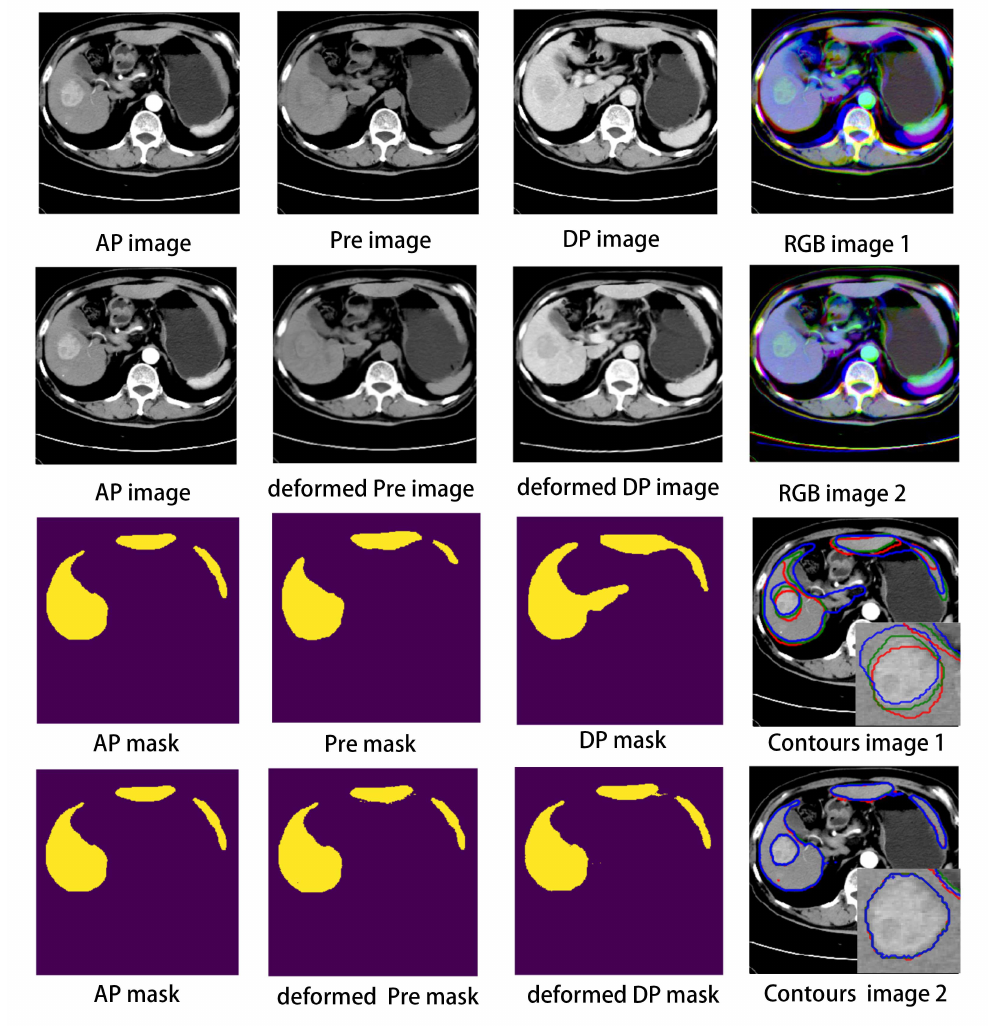
Figure 5. Registration illustration: RGB image shows AP, Pre, and DP image together without or with deformation. Contours image shows three mask contours on AP image without or with deformation.